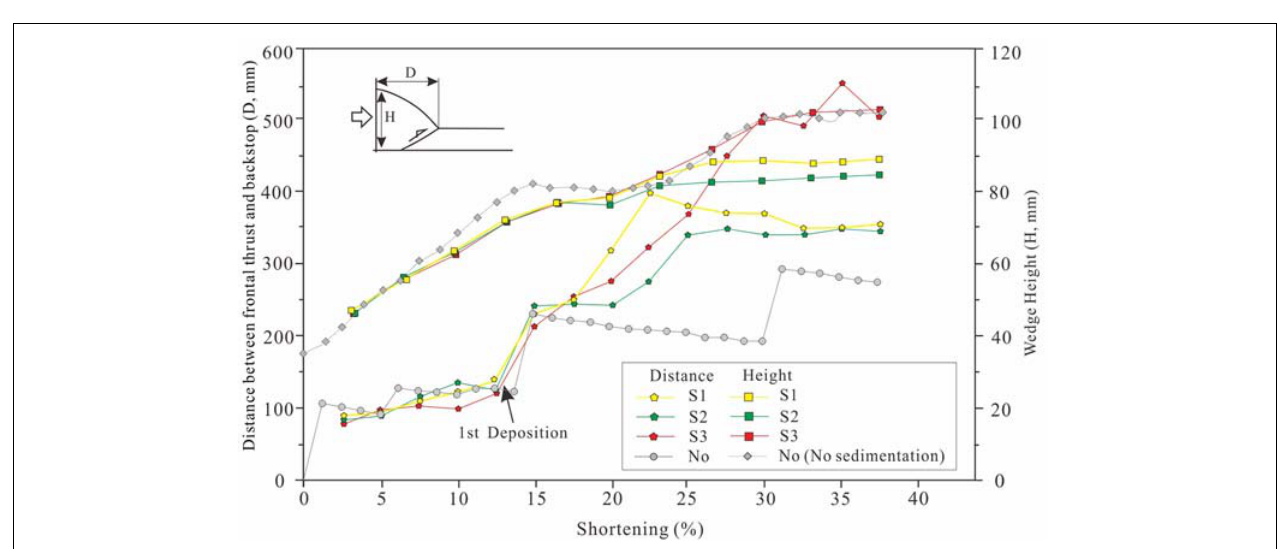
FIGURE 9 | Plot of geometries of accretionary wedge versus shortening in three sedimentation models.